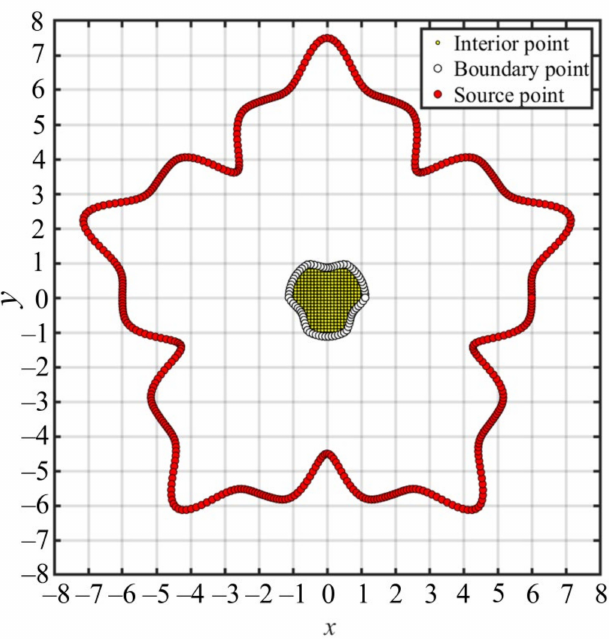
Figure 10. The fictitious